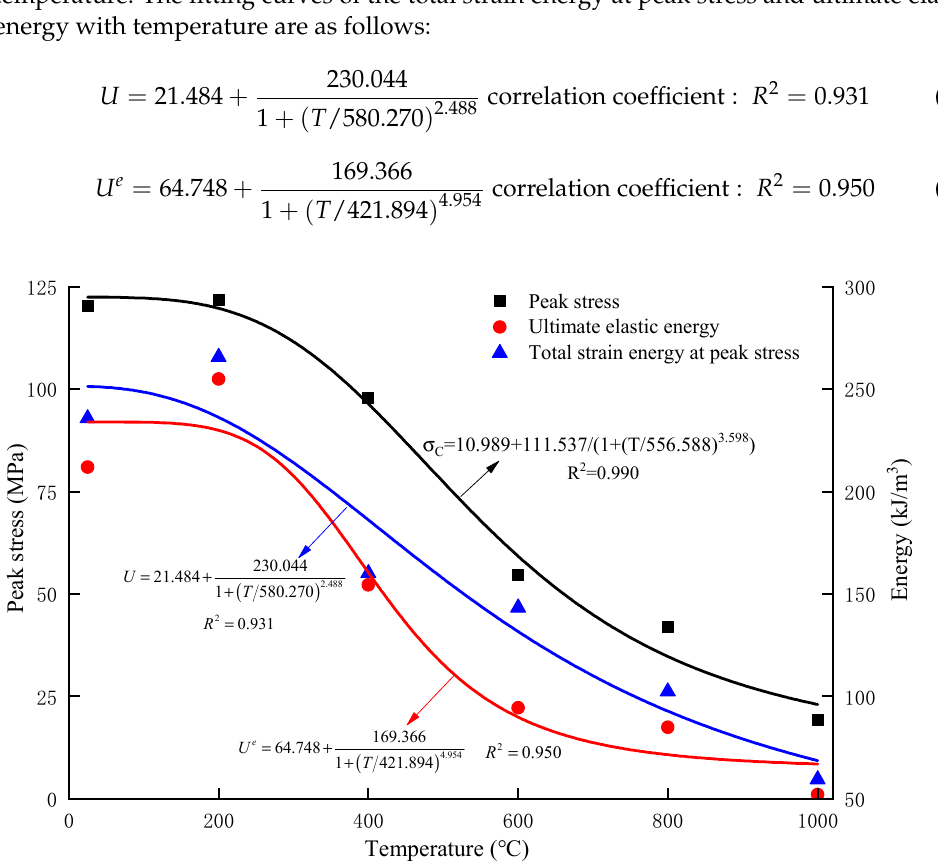
Figure 3. Variation of peak stress, ultimate elastic energy and total strain energy at peak value with temperature.